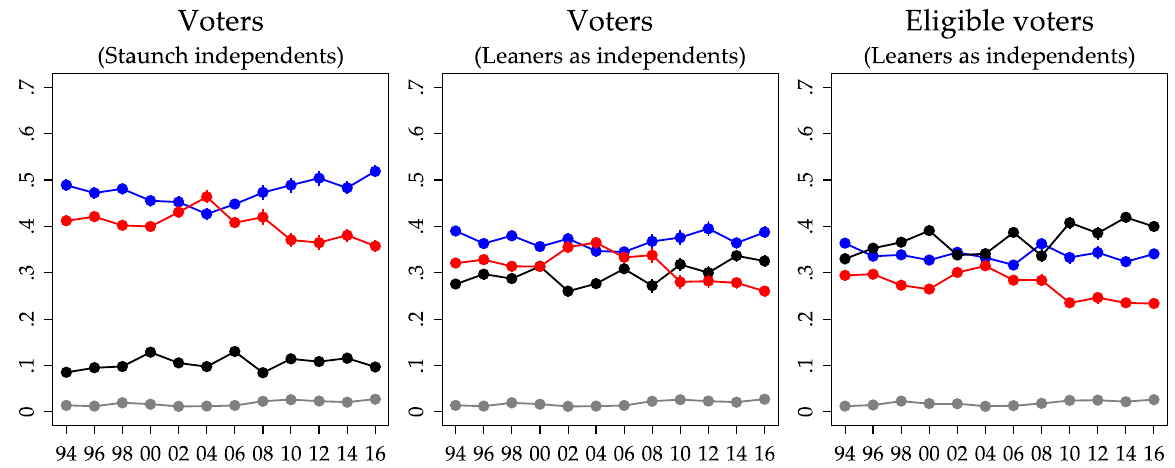
Figure 1: Trends in identification with the Democratic Party (blue), Republican Party (red), another party (gray), and independent (black). Notes : N = 21, 053 for panels 1 and 2, and N = 29, 029 for panel 3. Adding to the sample GSS respondents who reported that they were ineligible to vote in the last presidential election but reported a current party identification in the interview would boost the N to